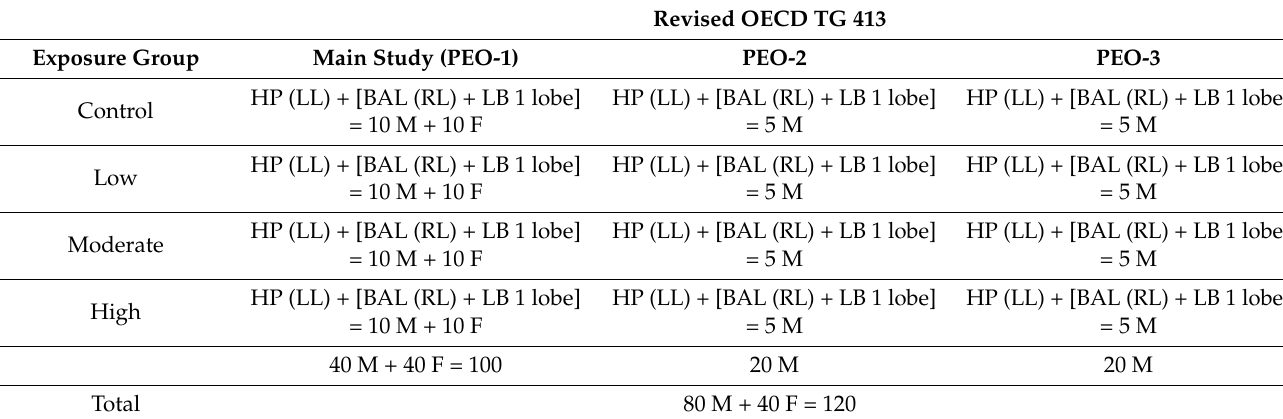
Table 5. Study design for TG 413 considering animal